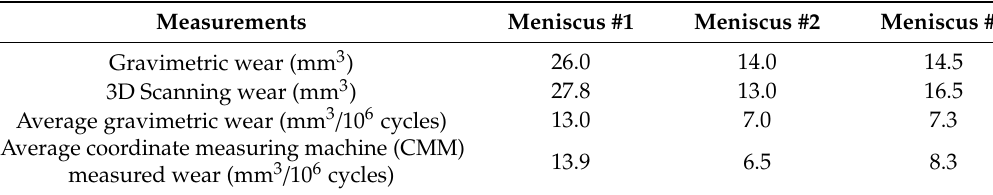
Table 3. Comparison of volumetric wear